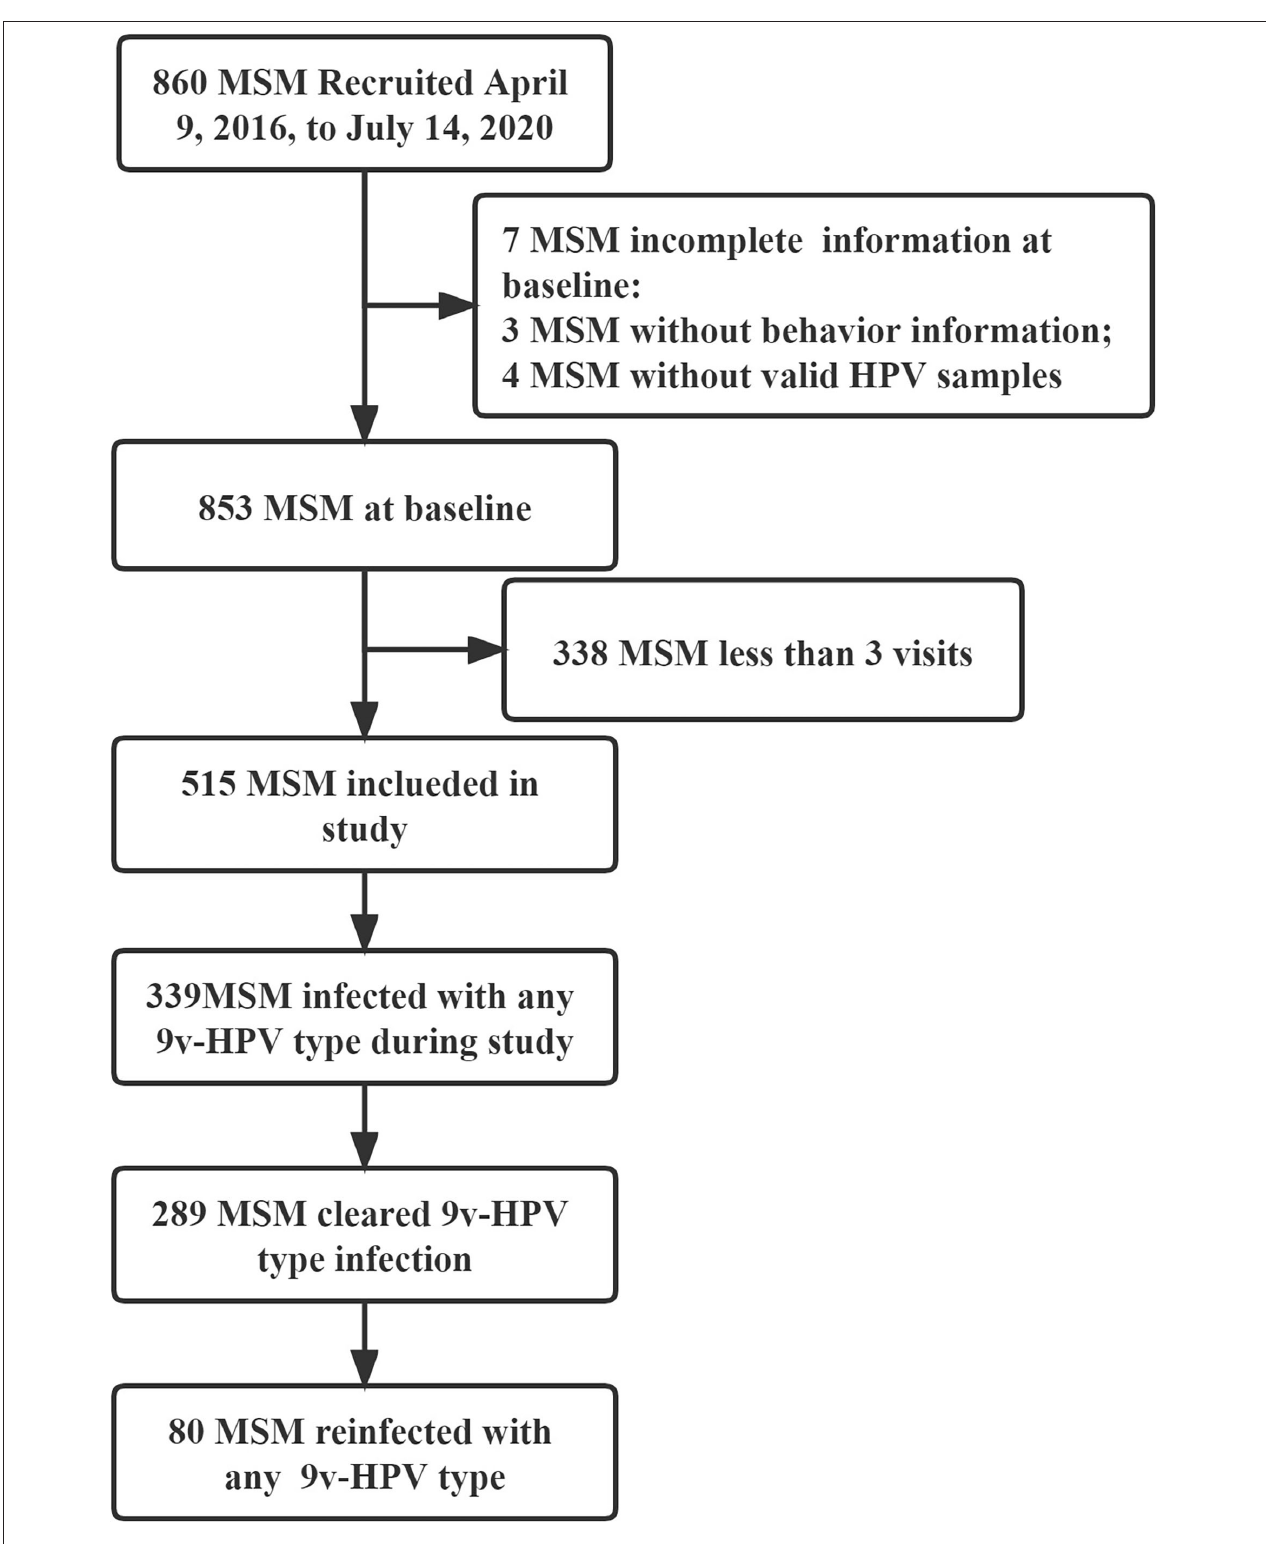
FIGURE 1 | Flowchart of human immunodeficiency virus (HIV)-negative men who have sex with men (MSM) for the study. MSM, men who have sex with men; HIV, human immunodeficiency virus; HPV, human papillomavirus; 9v-HPV, nine-valent HPV types, such as HPV6, 11, 16, 18, 31, 33, 45, 52, and 58.